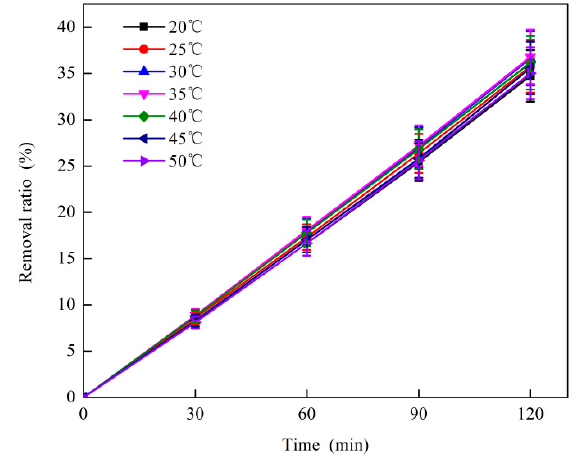
Figure 5. E ff ect of reaction temperature on O 3 catalytic oxidation of coking Figure 5. Effect of reaction temperature on O 3 catalytic oxidation of coking wastewater.